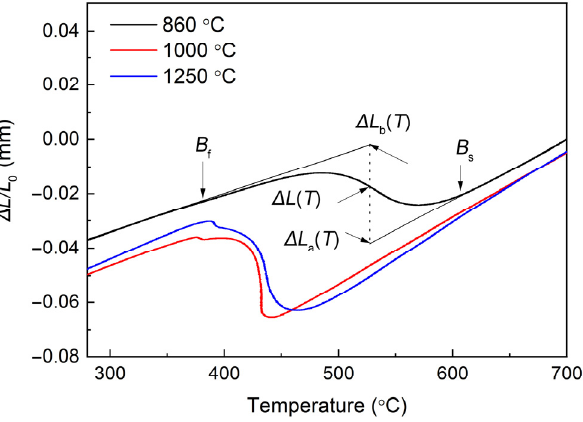
Figure 4. Expansion curves for the experimental steel subjected to different austenitizing tempera- tures.